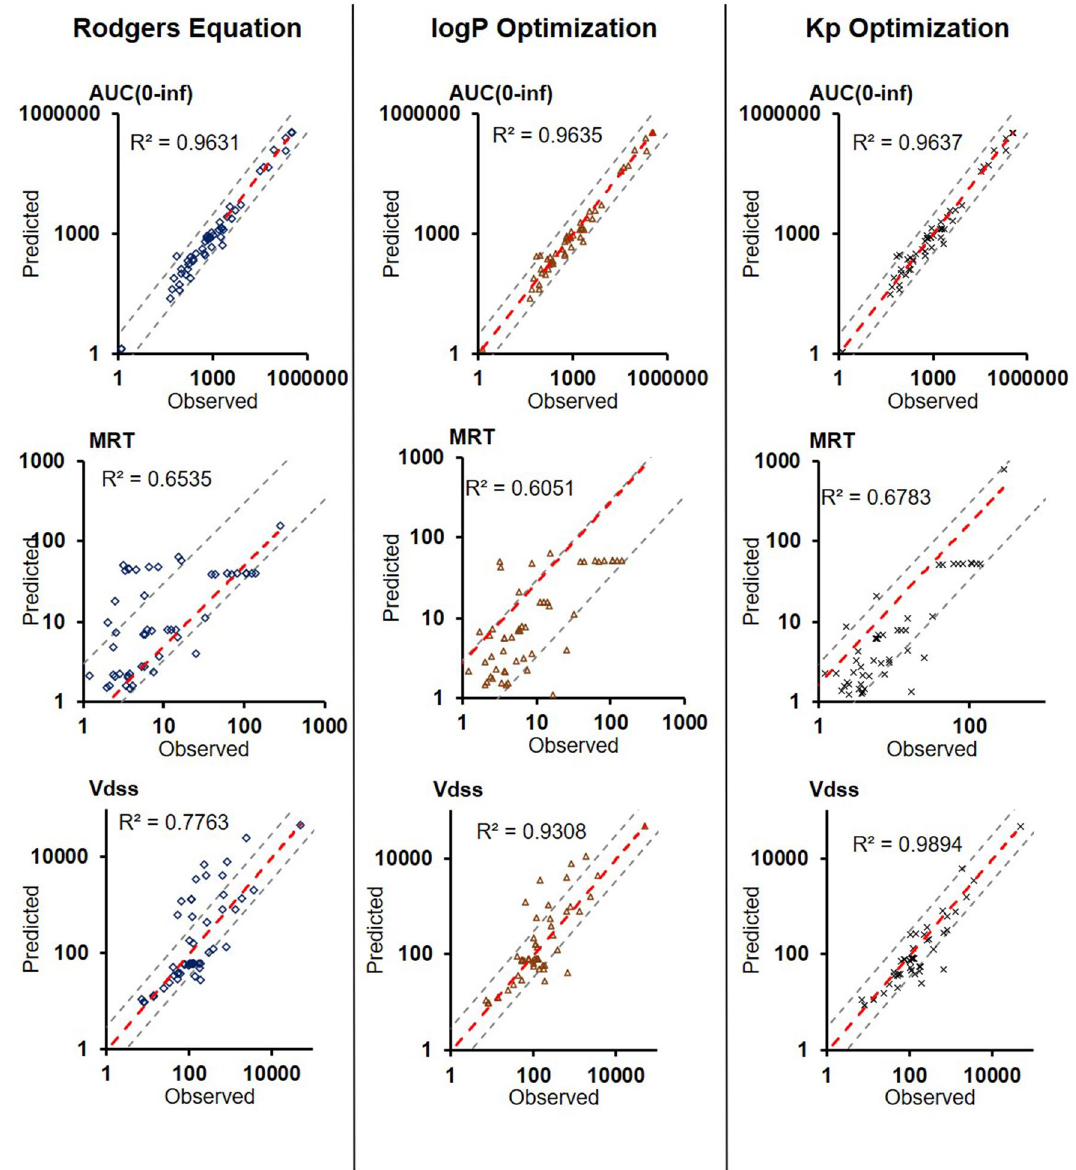
Figure 4. Plots of Observed vs. Predicted PK metrics across the different optimization conditions for second- order PK outputs. Red lines correspond to lines of best fit, gray lines are bounds of ±